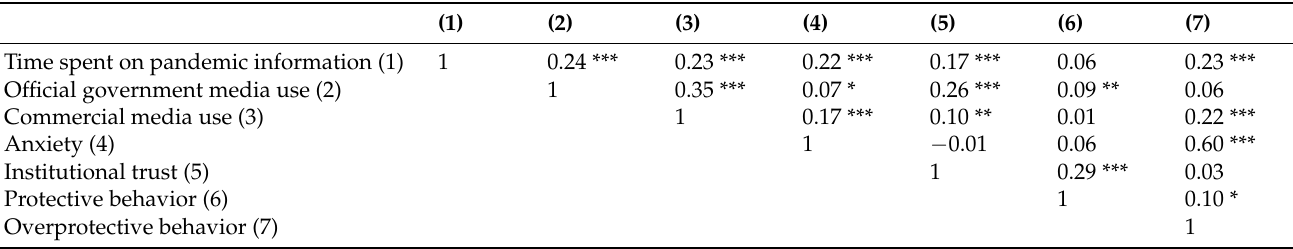
Table 2. Pearson correlation among the key